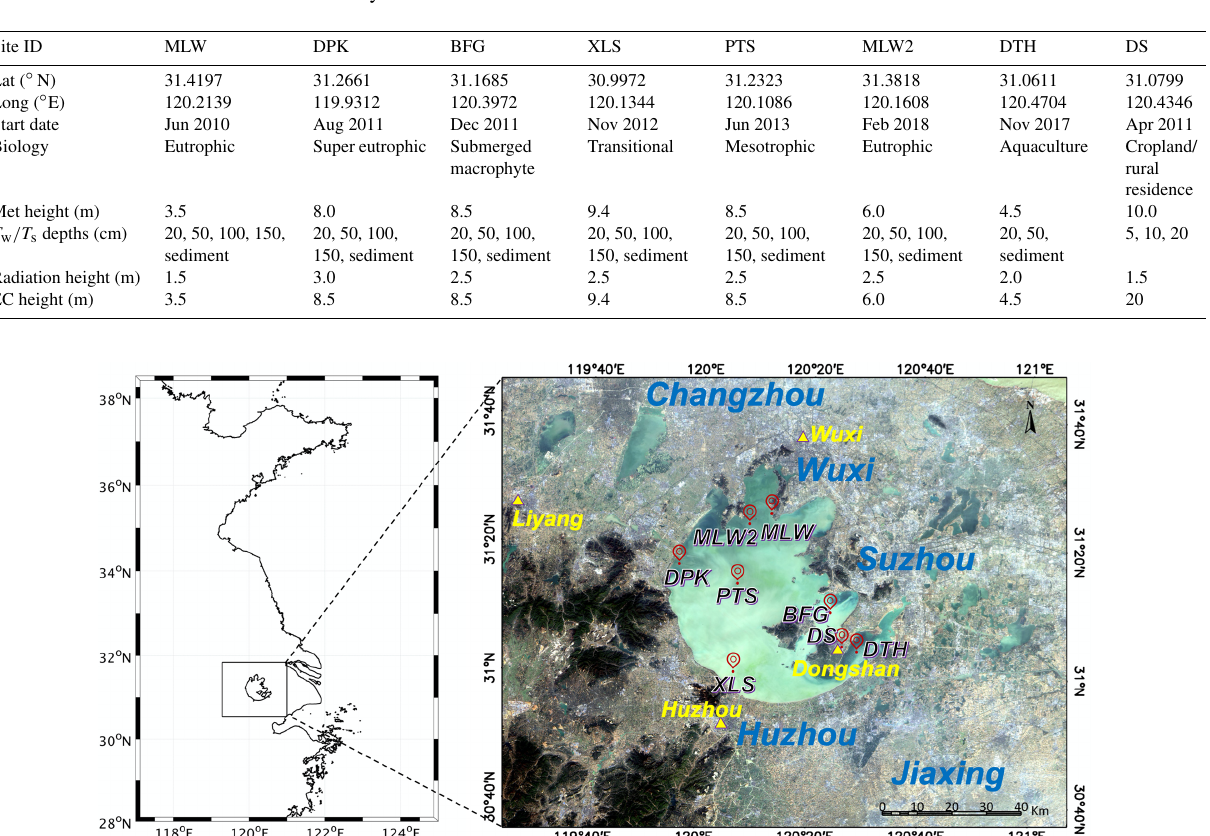
Table 1. A list of sites in the Lake Taihu eddy flux network.